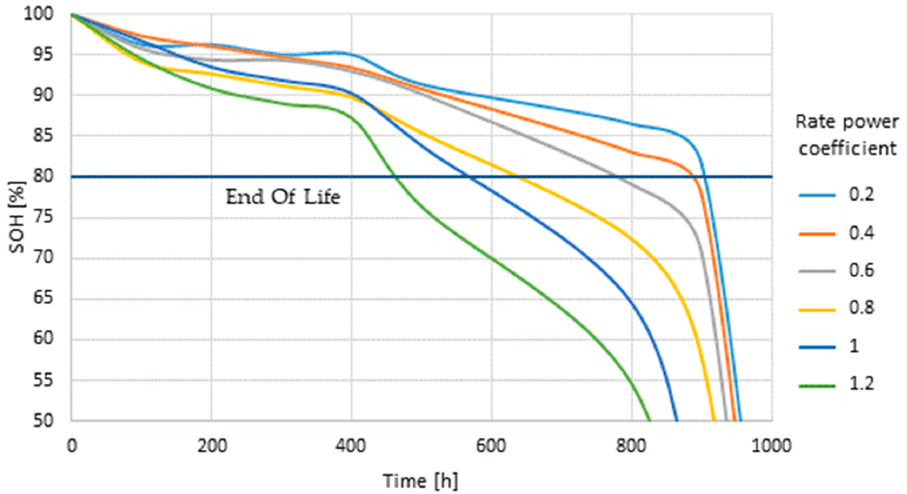
Figure 9. Load change amplitude—FC aging behavior.